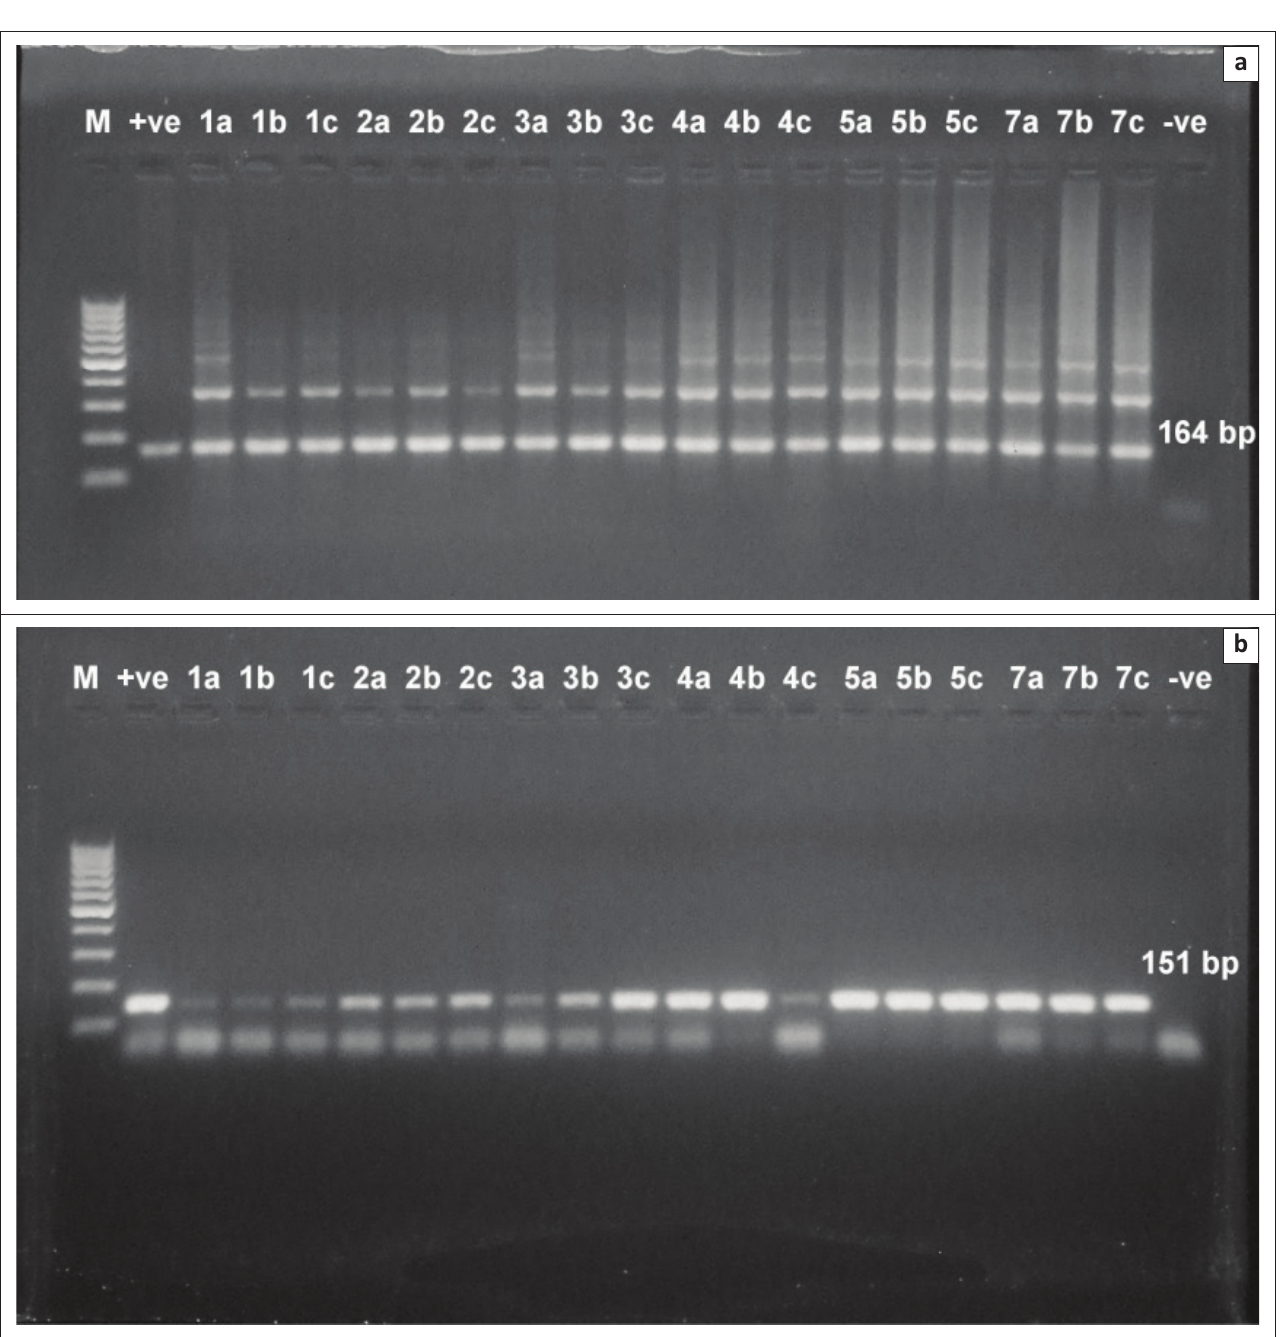
FIG URE 3: Direct polymerase chain reaction from mouse blood injected by 10 4 trypanosome. (a) Polymerase chain reaction amplification using Trypanosoma brucei 1/2 primer sets. The band 164 base pairs was high intensity and consistently visible throughout the course of infection. (b) Polymerase chain reaction amplification using T. evansi Rode Trypanozoon antigen type 1.2 primer sets. The bands intensity was clearly observed and increased gradually from the first day post infection until the peak of parasitemia. M: 100 base pair molecular weight Deoxyribonucleic acid marker, +ve: positive control, -ve: negative control, Numbers: days post infection. Letters: mice were sacrificed at day 1, 3, 5 and 7 post